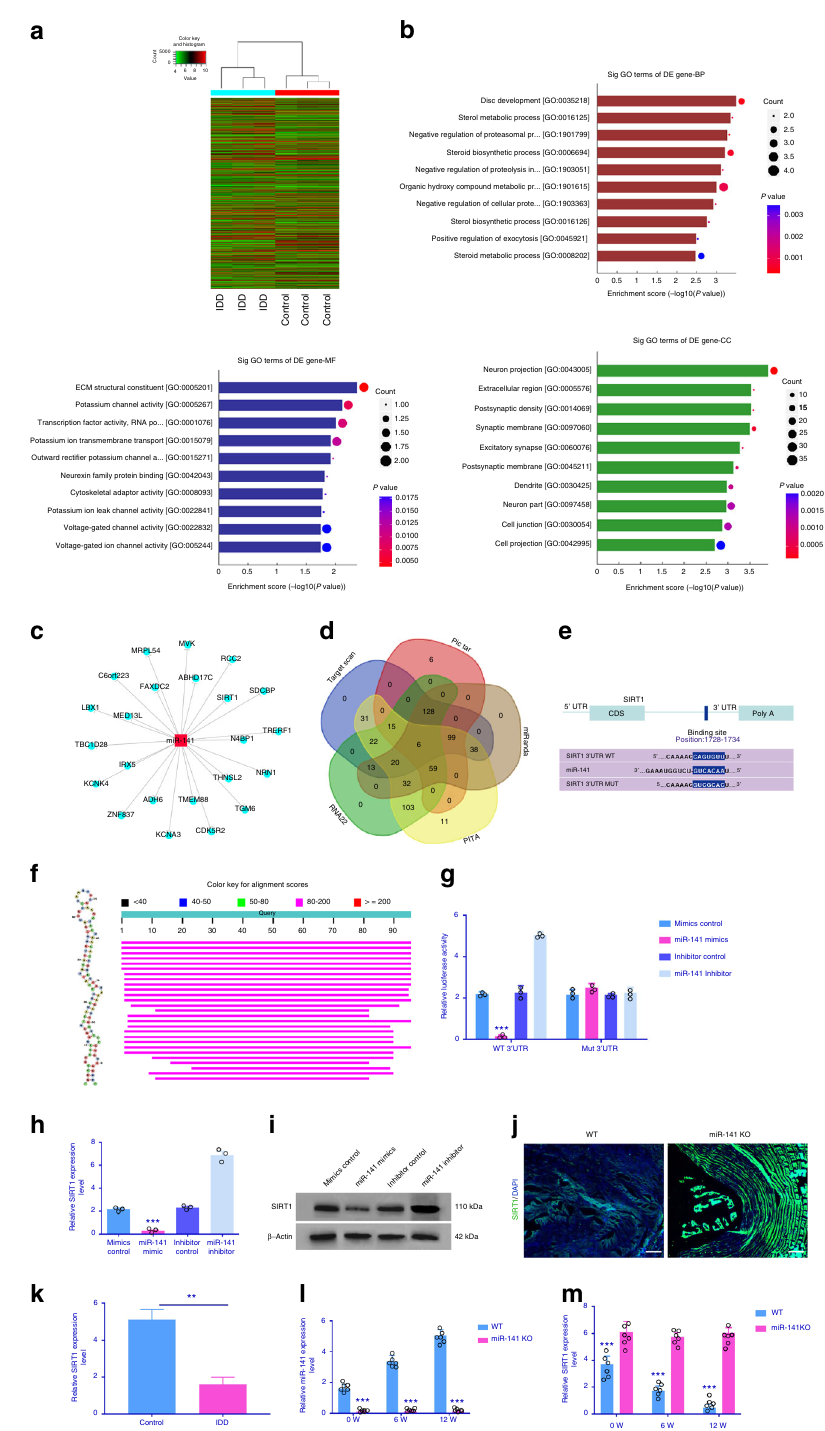
Fig. 4 Identi fi cation of SIRT1 as a target of miR-141. a Microarray analysis showing genes that were differentially expressed between IDD and control. b Downregulated GO terms with the most signi fi cant p values for biological processes, molecular function, and cellular component. c Cytoscape was employed to con fi rm the target of miR-141. d Venn diagram displaying miR-141 computationally predicted to target SIRT1 by different algorithms. e Sequence alignment of a putative miR-141-binding site within the 3 ’ UTR of SIRT1 mRNA shows a high level of sequence conservation and complementarity with miR-141. f High conservation of miR-141. g The wild- or mutant-type SIRT1 3 ’ UTR reporter plasmid was co-transfected with miR-141 mimics or inhibitor into cultured primary human NP cells. Forty-eight hours after transfection, luciferase activity was measured. n = 3 replicates per group, *** p < 0.001 by one-way ANOVA test followed by Tukey ’ s post hoc. h – j SIRT1 expression level was detected by qRT-PCR, western blot in primary human NP cells, and immunostaining. *** p < 0.001 by one-way ANOVA test followed by Tukey ’ s post hoc. Scale bar = 100 μ m. k Compared with controls, SIRT1 expression level in IDD patients was lower. ** p < 0.01 by Mann – Whitney U test. l , m MiR-141 level in NP tissues from miR-141 KO mice was lower than that in WT mice, while SIRT1 level in NP tissues from miR-141 KO mice was higher than that in WT mice. ** p < 0.01 by Mann – Whitney U test. Data shown as mean and error bar represents